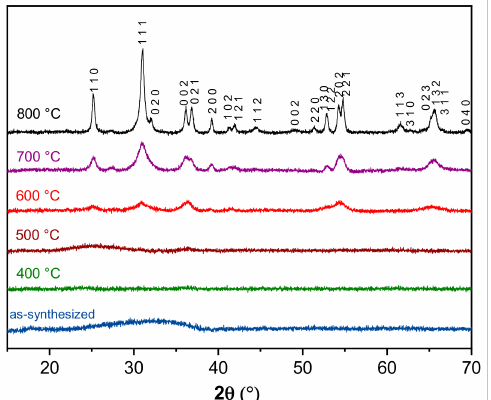
Figure 1. Evolution of the XRD patterns of Fe 2 WO 6 synthesized by polyol method from 30 ◦ C up to 800 ◦